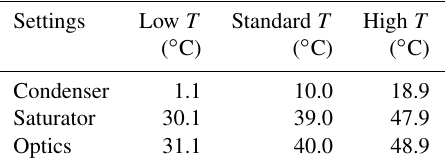
Table 1. Temperature settings of the three TSI 3776 UCPCs used in this study in